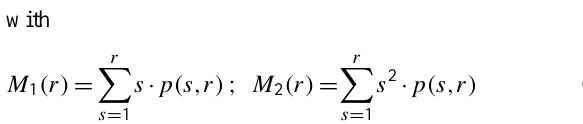
most relevant changes in lacunarity are always detected be- fore the critical value r c , Fig. 3 represents the geographical distribution of parameters α 1 and β 2 and critical lengths r c , for the four thresholds R 0